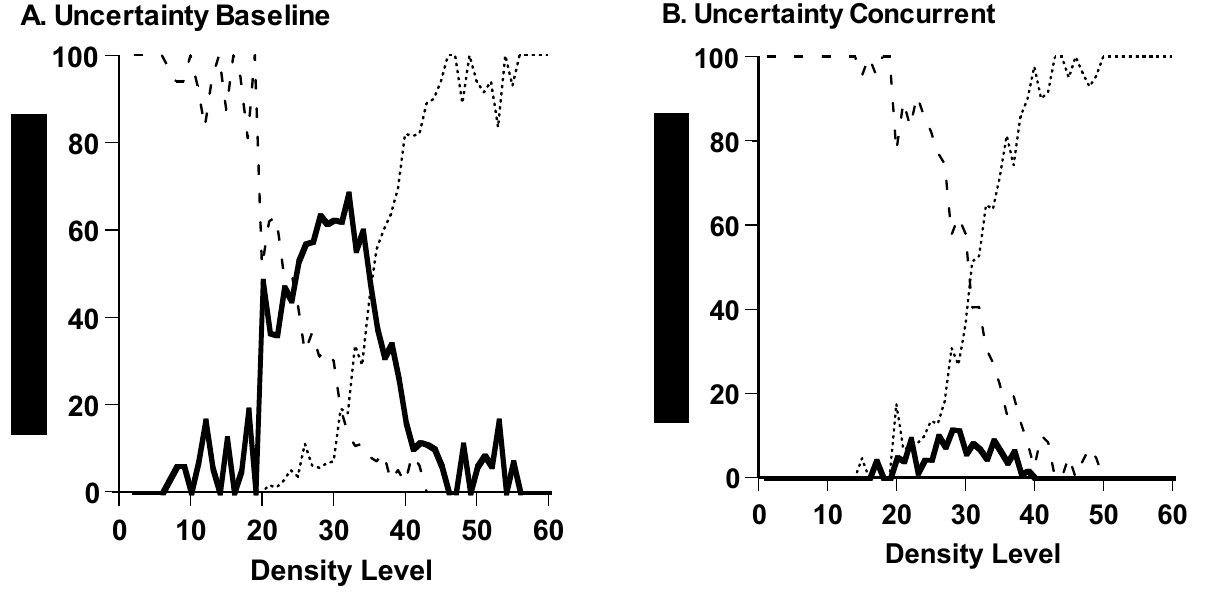
Figure 3. Percentage of uncertainty responses (solid line), sparse responses (dashed line), and dense responses (dotted line) made by macaques Murph and Lou in their baseline performance ( A ) and in their first phase of concurrent-load testing ( B ). From “Executive -Attentional Uncertainty Responses by Rhesus Macaques ( Macaca mulatta ),” by J. D. Smith, M. V. C. Coutinho, B. A. Church, & M. J. Beran, Journal of Experimental Psychology: General, 142 , 472 . Copyright 2013 by the American Psychological Association. Reprinted with